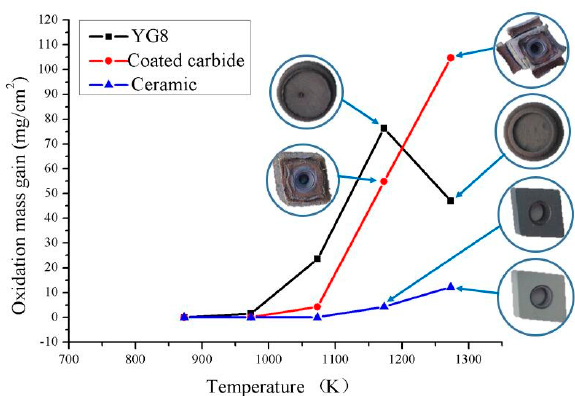
Figure 5. Oxidation mass gain curves of different tool materials versus temperature. (The insets indicate the changes in physical form and colour of the tool materials ） .